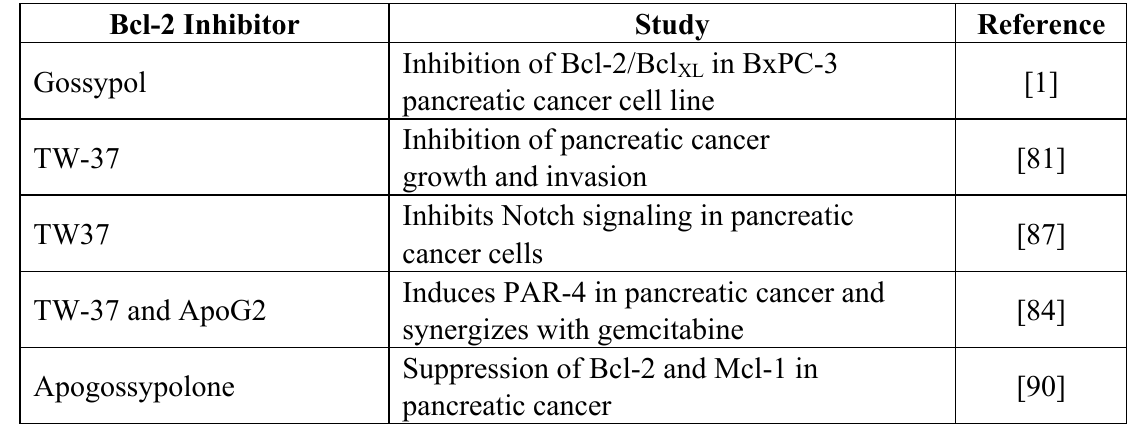
Table 1. Pancreatic cancer studies using Bcl-2